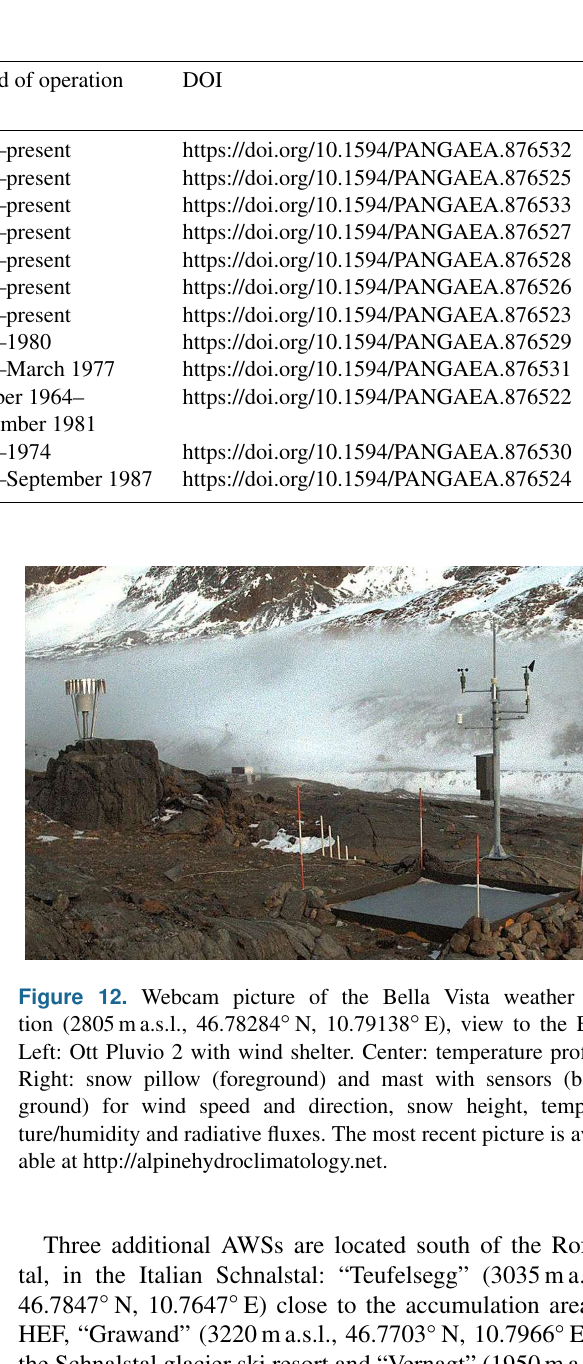
tal, in the Italian Schnalstal: “Teufelsegg” (3035 m